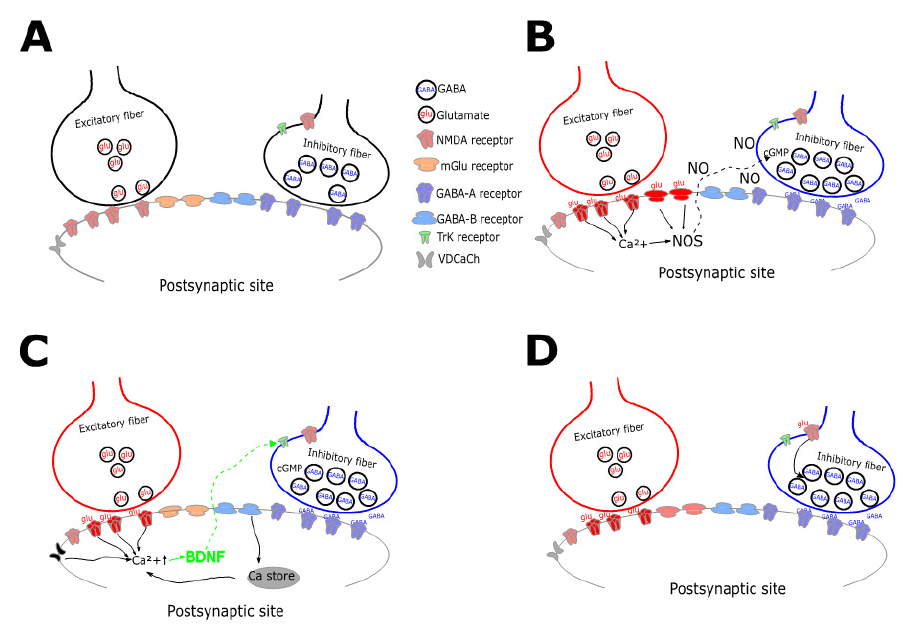
Figure 1. Schematic diagram collecting mechanisms underlying presynaptic LTP. A. Excitatory and inhibitory fibers contact, by releasing glutamate (glu) and GABA (GABA), a postsynaptic neuron expressing both ionotropic (mglu) and metabotropic receptors (GABA-B). B The repetitive release of glutamate triggers calcium entry through NMDA receptors in the postsynaptic terminals. The activation of Nitric Oxide (NO) synthase (NOS) induces the retrograde di ff usion of NO which, in turn, activates cyclic-GMP potentiating vesicles release. C. Similarly to B, the repetitive glutamate release causes postsynaptic intracellular calcium rise in response to i) Voltage-dependent Calcium Channels (VDCaCh) opening, ii) NMDA receptors opening, or iii) mGlu receptors activation causing release from intracellular stores. Calcium increase triggers the retrograde di ff usion of the Brain-Derived Neurotrophic Factor (BDNF) potentiating GABA release via Tyrosine Kinase-1 (TRK) receptors activation. D. The di ff usion of glutamate in the extrasynaptic space can directly activate presynaptic NMDA-Rs favoring the potentiation of GABA release.